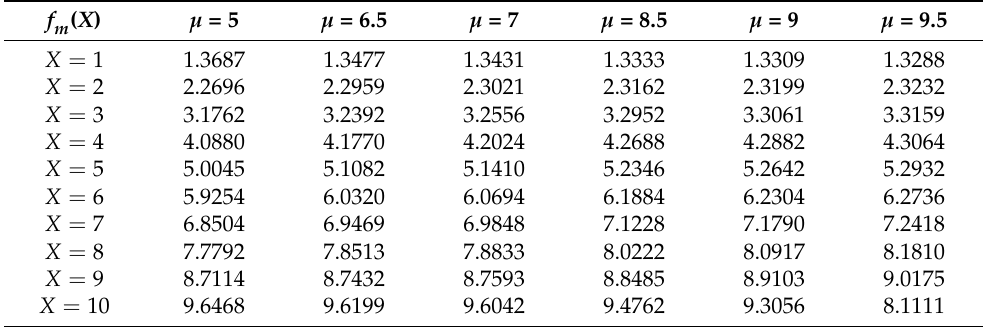
Table 1. Dependence of the function f m ( X ) value on the parameter µ and the grade X in case 3. f ( X ) m